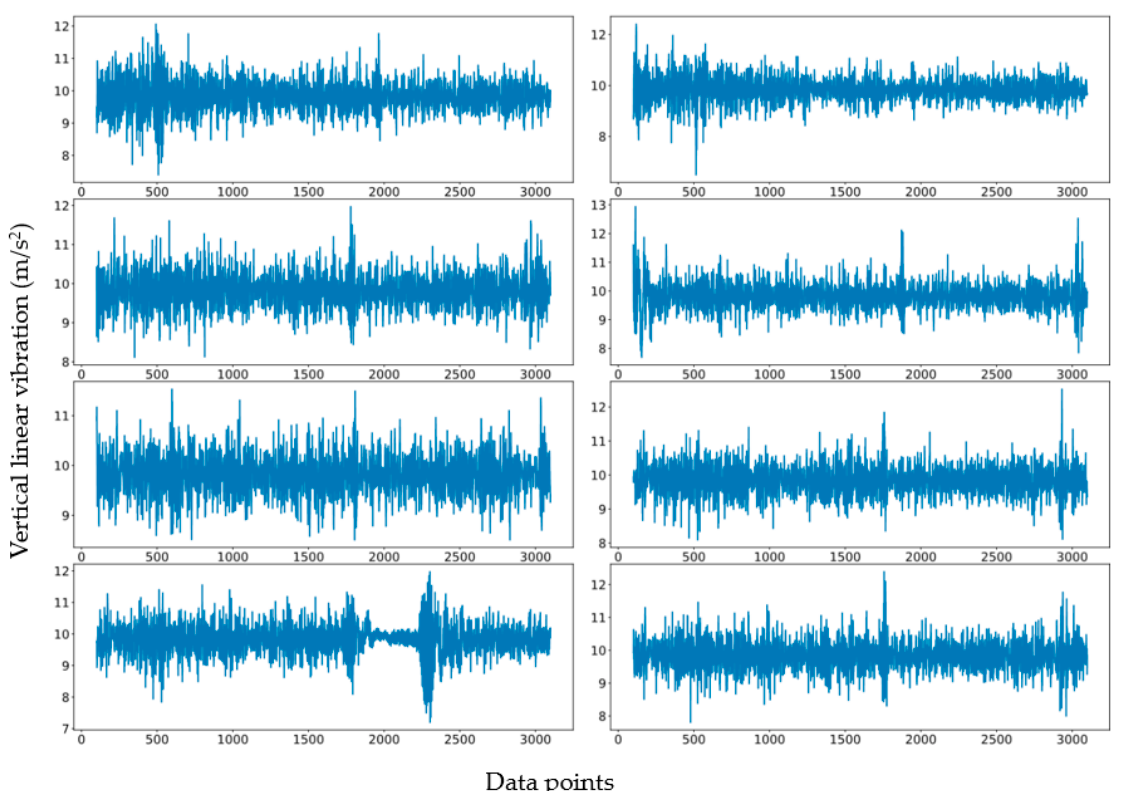
Figure 2. The collected accelerometer raw data (vertical linear vibration in the vertical axis and data points in the horizontal axis) from eight repeated and independent runs in one direction.